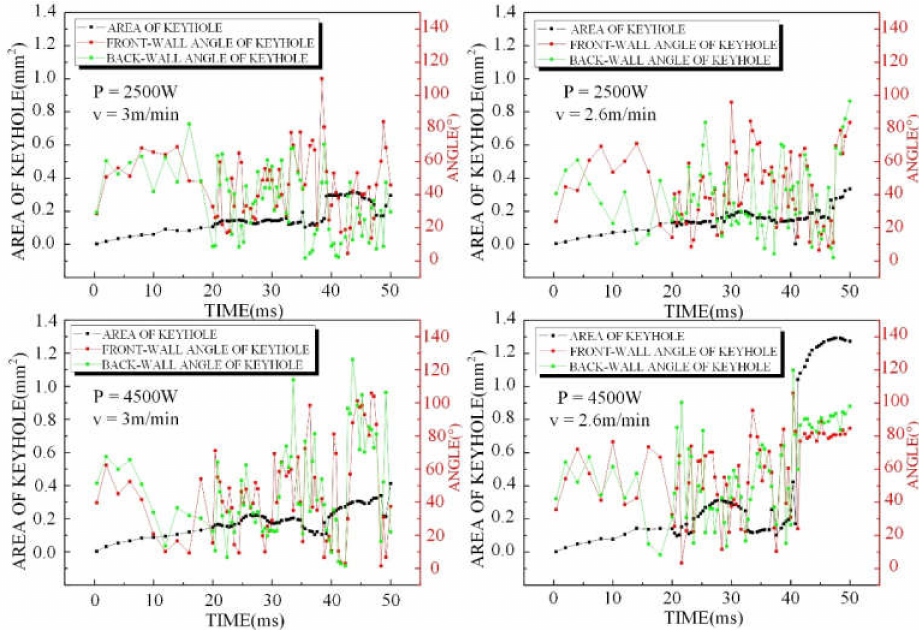
Figure 13. Effect of process parameter on area of keyhole, front wall angle of keyhole, and back wall angle of